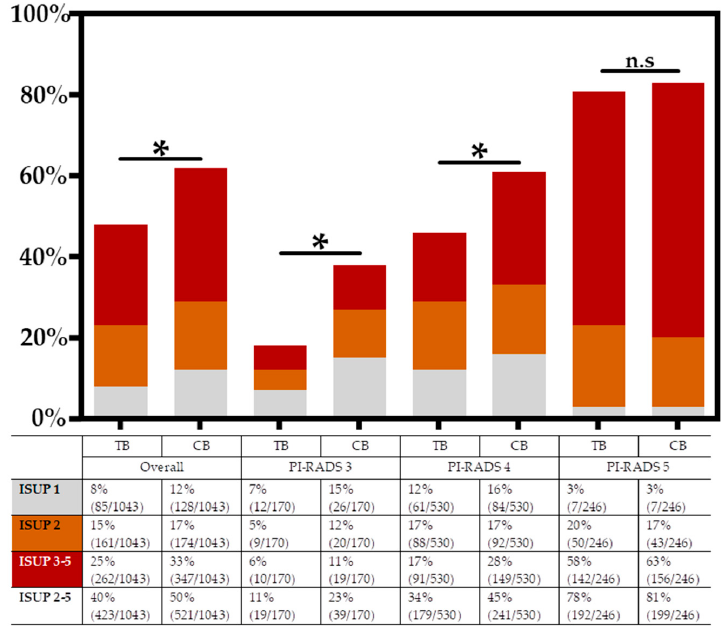
Figure 2. Cancer Detection Rates stratified by PI-RADS score and biopsy method. Additional systematic biopsy diagnosed significantly (*) more clinically significant prostate cancer (sPC) in the total cohort and in the subgroups of PI-RADS 2–4 men. For the group of men with a PI-RADS 5 lesion this difference was not statistically significant (n.s) when considering the overlap of 95% confidence intervals: sPC by TB was 78.0% (73.0–83.0%) vs. 80.9% (75.9–85.8%) for CB. TB—MRI-targeted biopsy;